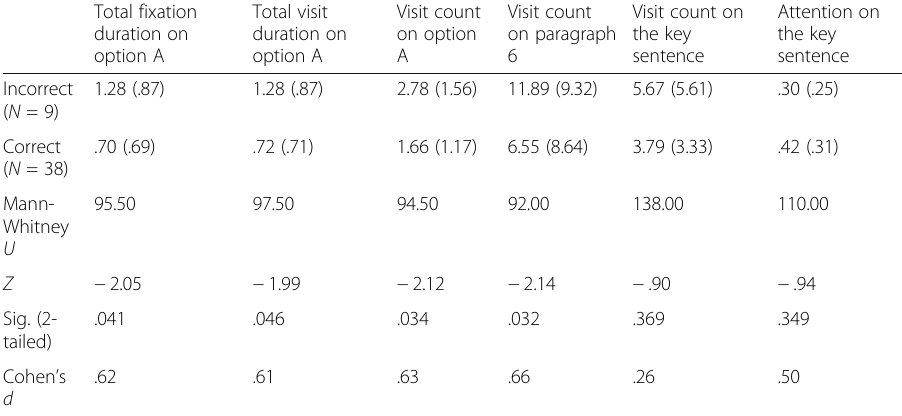
Table 5 Eye-tracking statistical results for item